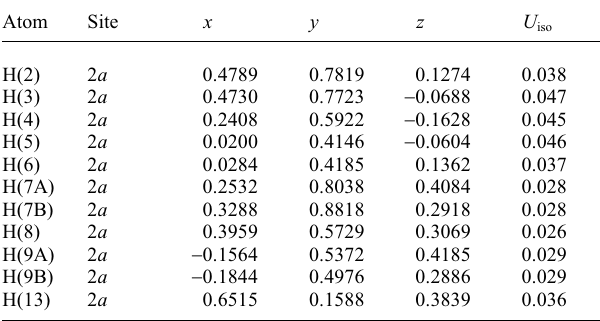
Table 2. Atomic coordinates and displacement parameters (in Å 2 )